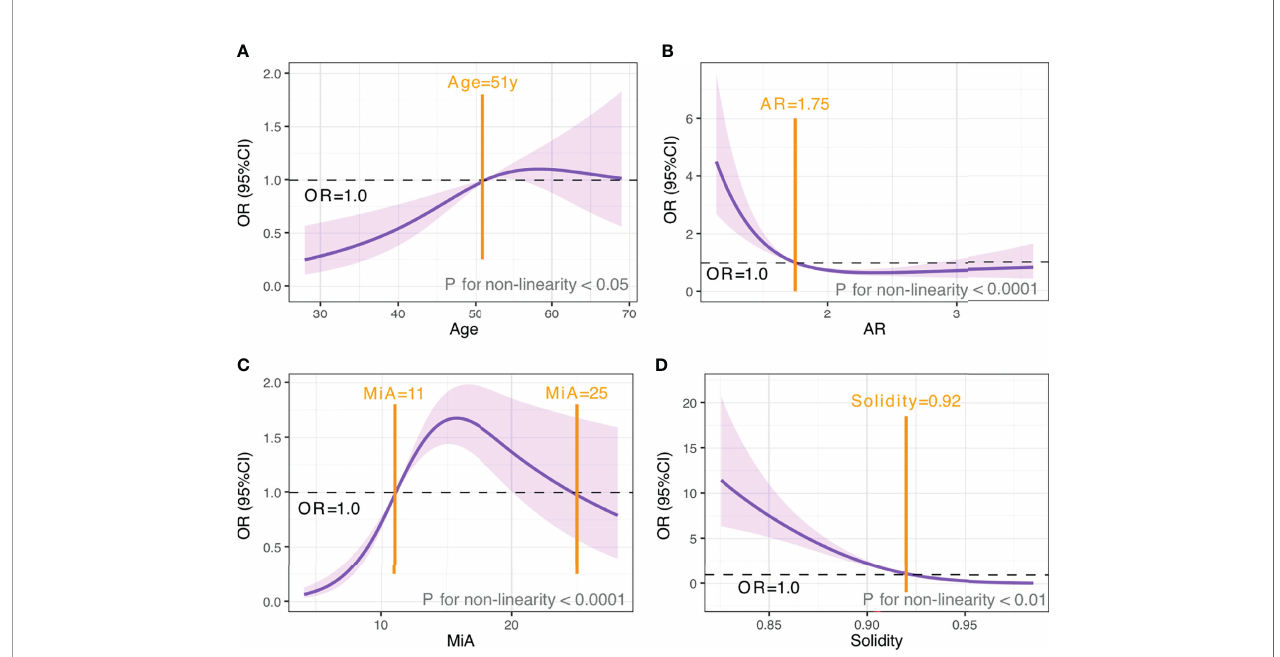
FIGURE 5 | The relationship between age and morphometric features with malignancy risk. OR and 95% CI for age (A) , AR (B), MiA (C) , and Solidity (D). The analyses used restricted cubic splines. Purple shaded areas, 95% CIs. Black horizontal dotted line, OR=1.00. Yellow vertical solid line, cut-off value.